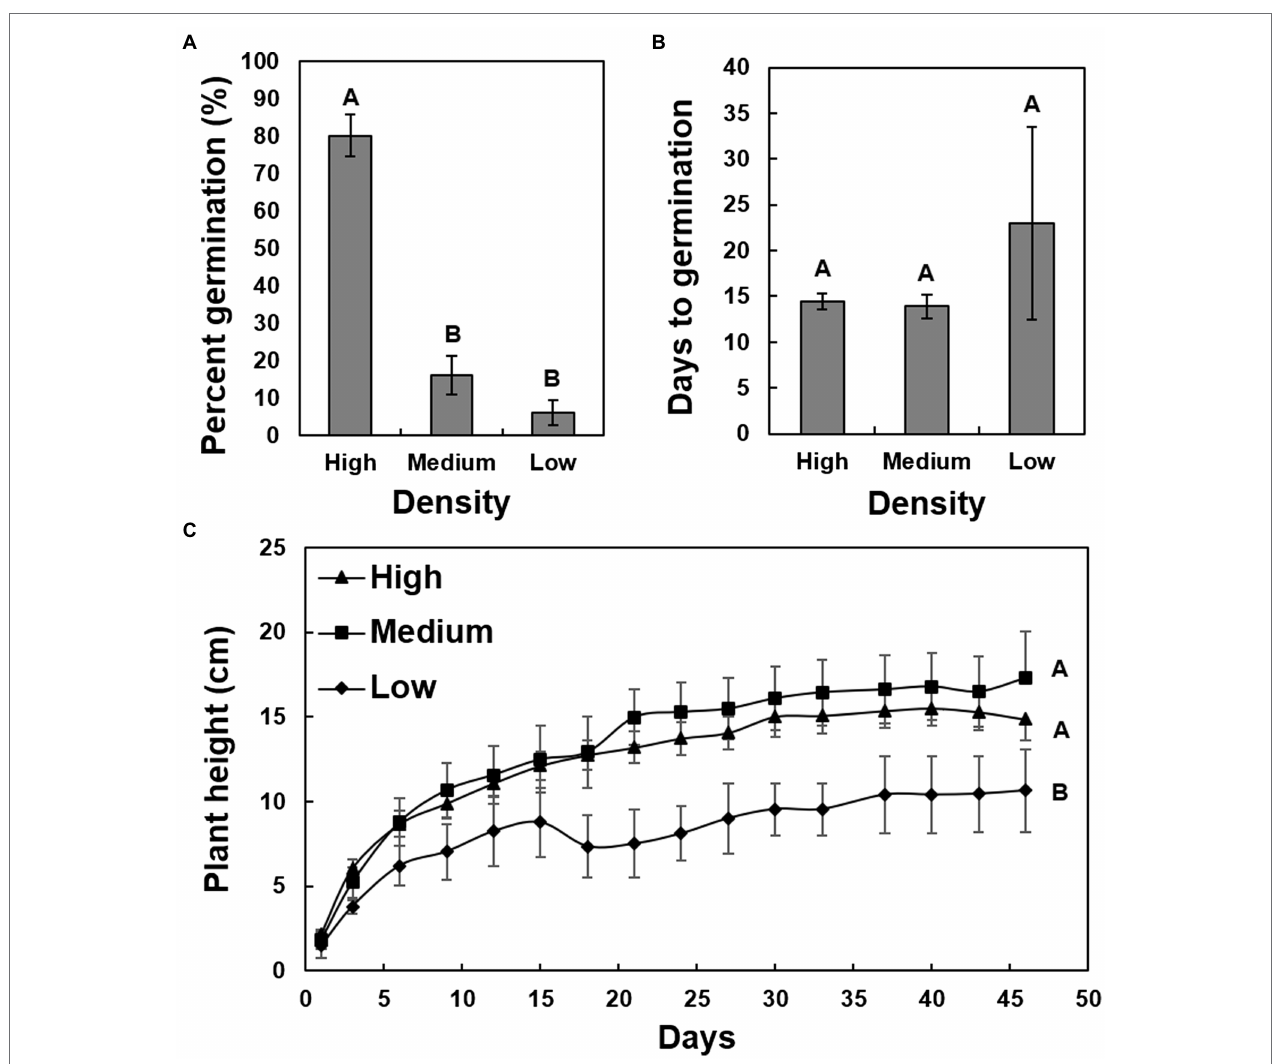
FIGURE 3 | The impact of seed density on the germination and growth rate of seedlings of cultivar Cape Fear. A total of 150 seeds were collected from a pecan bacterial leaf scorch-diseased tree, measured for seed density, and separated into three groups. The average seed density of each group was as follows: high- density seed (0.72 g/cm 3 ), medium-density seed (0.62 g/cm 3 ), and low seed density (0.52 g/cm 3 ). (A) Comparison of germination (%) of high-, medium-, and low- density seeds. (B) The average days to germination for high-, medium-, and low-density seeds. (C) Growth rate of seedlings germinated from the three different categories of seeds. Error bars indicated standard errors of the mean values. Means with different letters are significantly different based on Tukey’s HSD ( α =